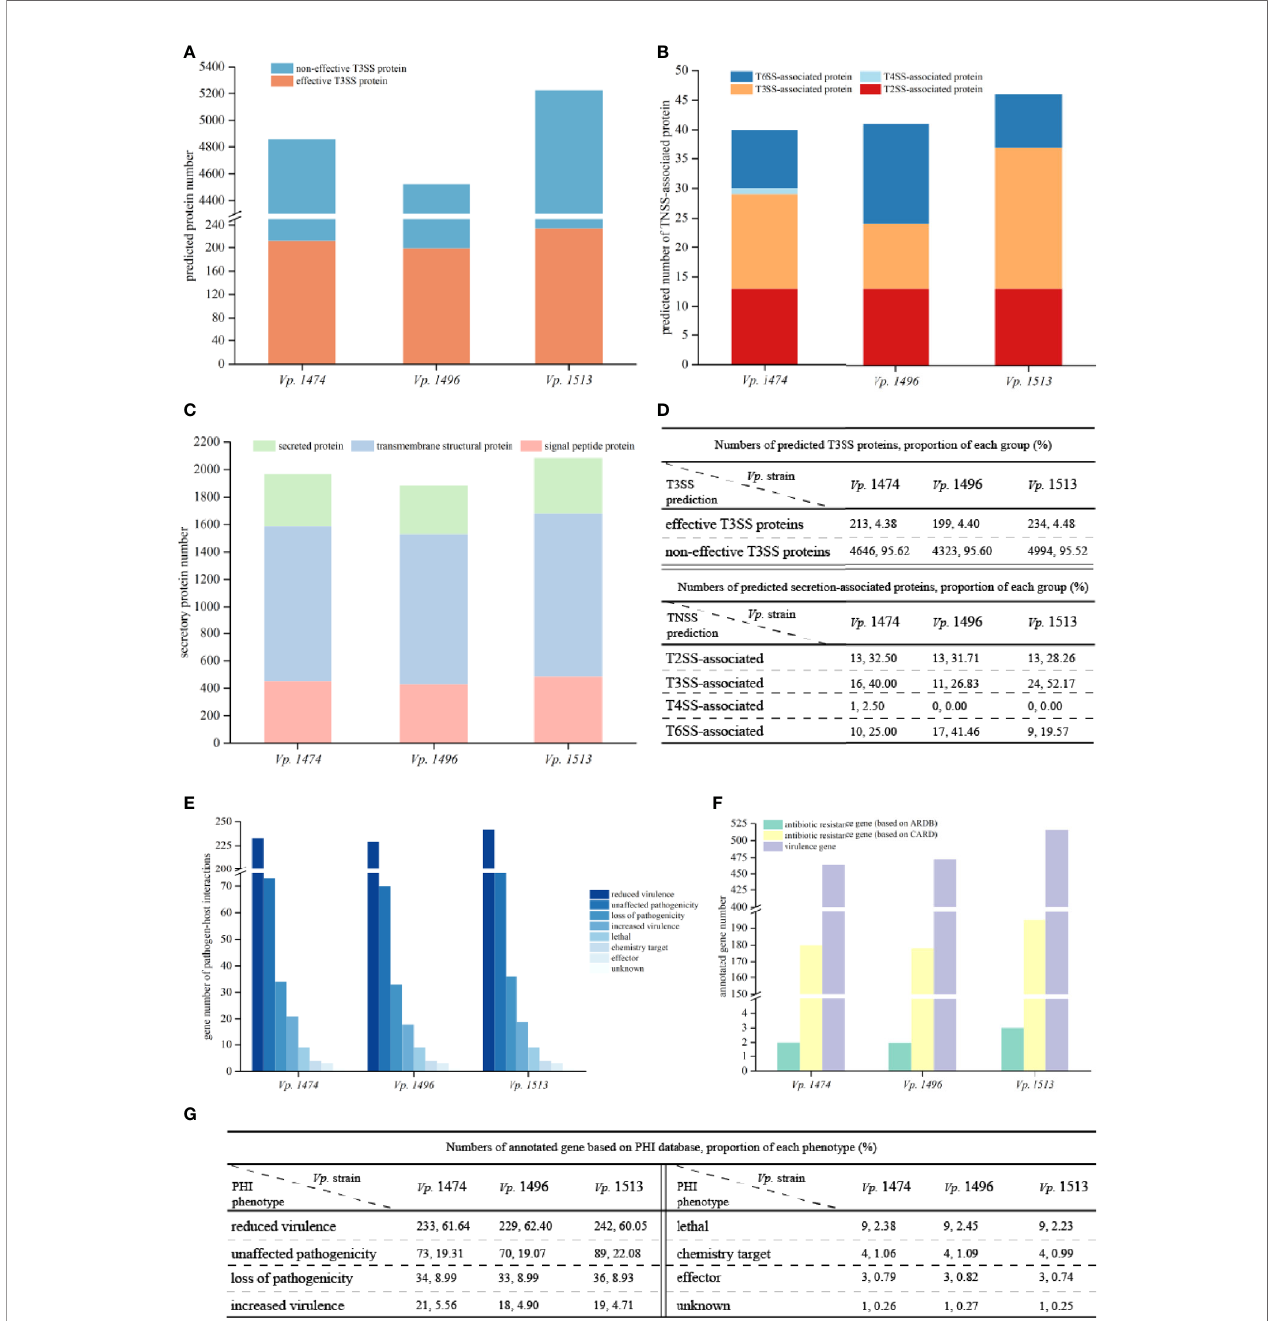
FIGURE 6 | Virulence and pathogenicity analysis of V. parahaemolyticus strains Vp . 1474, Vp . 1496, and Vp . 1513. (A) Accumulative bar diagram of protein distribution in Type III secretion system (T3SS) of the three strains. T3SS were predicted and divided into effective and non-effective proteins, and their numbers are shown on the Y-axis. (B) Accumulative bar diagram of protein distribution in major Type N secretion system (TNSS) of the three strains. Four major TNSS were predicted in the three strains, viz., T2SS, T3SS, T4SS, and T6SS, and the number of TNSS-associated proteins are shown on the Y-axis. (C) Accumulative bar diagram of secretory proteins distribution of the three strains. Secretory proteins were divided into 3 groups, namely secreted proteins, transmembrane structural proteins, and signal peptide proteins. Numbers and detailed distribution of proteins are shown on the Y-axis. (D) Statistical data of predicted T3SS and other secretion-associated proteins for the three strains. (E) Statistical histogram of genes that are involved in pathogen-host interaction of the three strains. A total of 8 classes were predicted within genome genes of the three strains. Gene numbers are shown on the Y-axis. (F) Statistical histogram of genes annotated to antibiotic resistance and virulence of the three strains. Genes associated with antibiotic resistance were predicted and aligned with CARD and ARDB databases; genes annotated to virulence were predicted and aligned with VFDB database. Detailed numbers are shown on the Y-axis. (G) Statistical data of gene annotation based on PHI database for the three